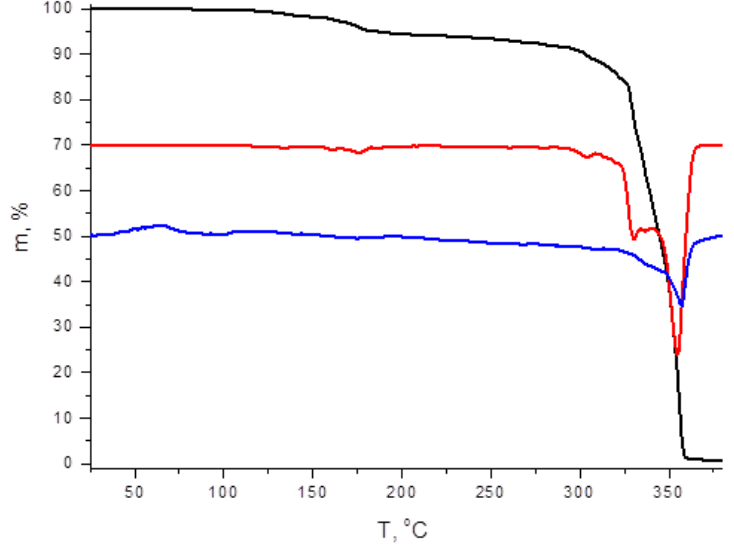
Figure 4. TG, DTG, and DTA curves of 1 .